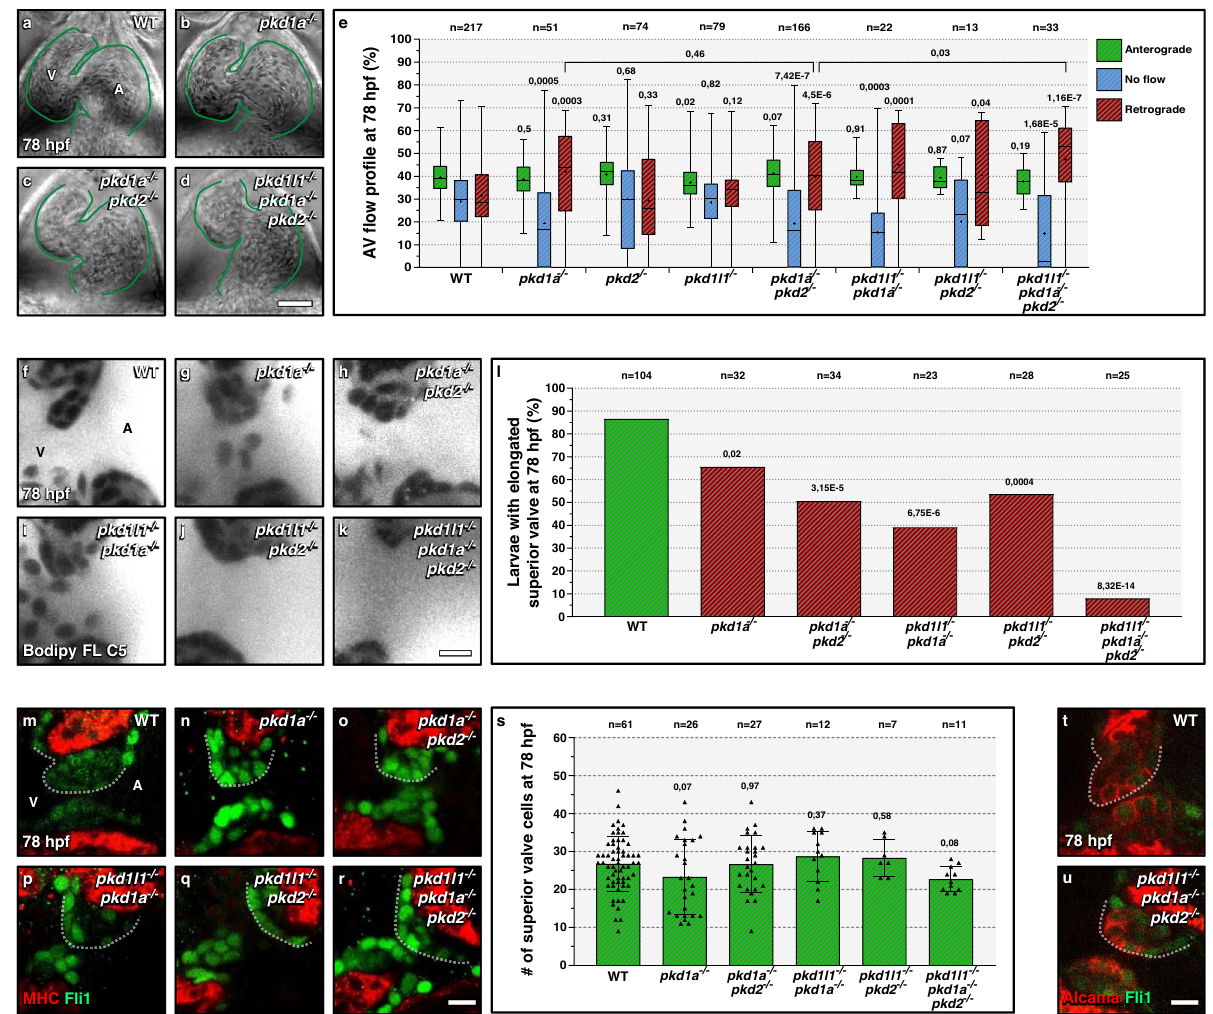
s Superior AV valve cell number in 78 hpf wild types, pkd1a mutants , pkd double mutants, and pkd triple mutants. t , u Confocal imaging of 78 hpf wild-type ( t ) and pkd triple mutant ( u ) hearts immunostained for Alcama and Fli1; 10/10 of the wild- typeand9/9ofthe pkd triplemutantlarvaedisplayluminalandabluminalsuperior valve cells; AV canal magni fi ed images. Hearts imaged in ventral view, anterior to the top, ventricle (V) on the left and atrium (A) on the right. The center ofthe box- and-whiskerplotrepresentsthemedian;eachofthebox-and-whiskersrepresentsa quartile; “ + ” represents the mean in e . The center of the error bar represents the mean in l , s . Error bars indicate s.d in s . P values were calculated using a two-sided Student ’ s t -test in e , s ; a two-sided Fisher ’ s exact test in l ; and are relative to wild type except when a horizontal bar is used. Scale bars: 50 µ m in a – d ; 10 µ m in f – k , m – r , t , u . Source data are provided as a Source Data fi